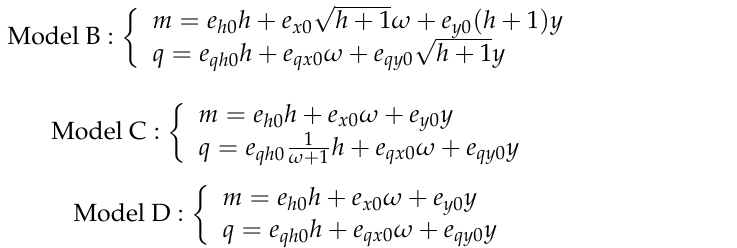
Figure 7. Phase space trajectories of x , y , ω for S 1 , S 2 , S 3 and S 4 . ( a ) S 1 ; ( b ) S 2 ; ( c ) S 3 ; ( d ) S 4 .